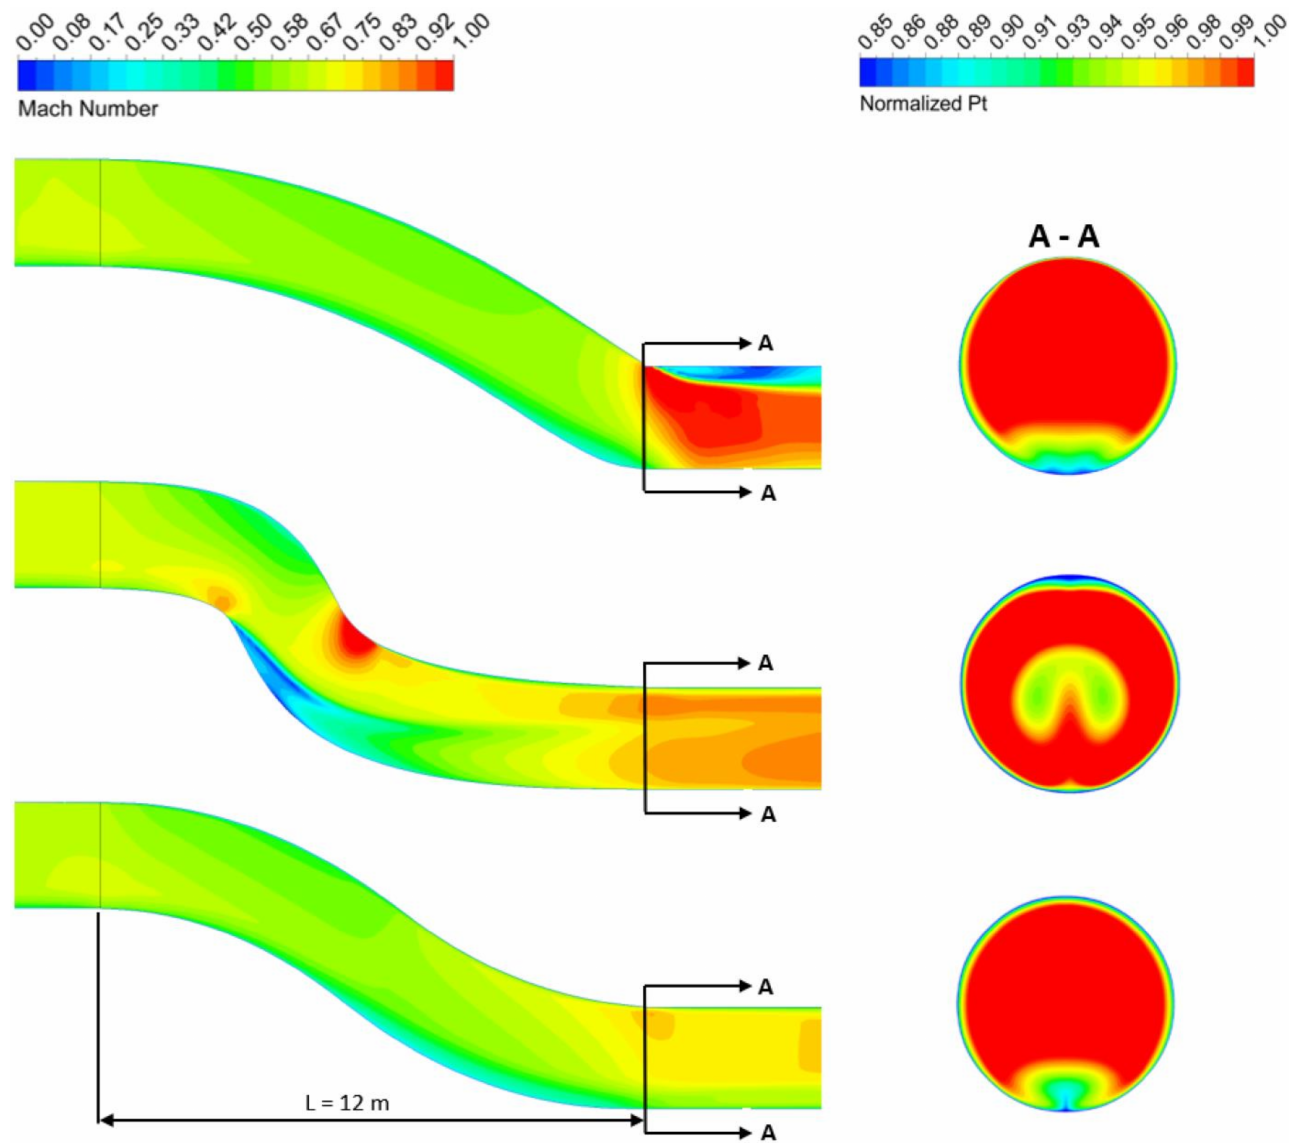
Figure 19. Comparison of the symmetry plane Mach number contours and the normalized total pressure distribution at the engine inlet (top: Opt. PR (Design II); middle: Opt. Dist. (Design VIII); bottom: original (Design